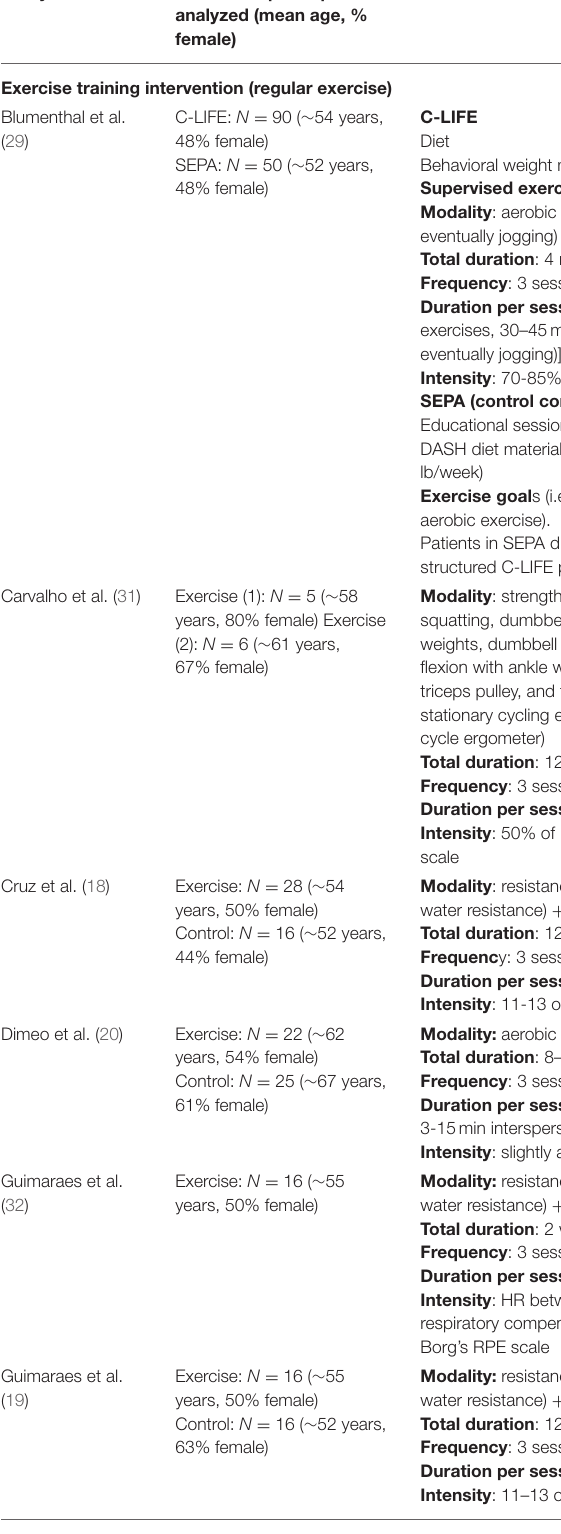
TABLE 1 | Main characteristics of the included studies. Study Number of participants Exercise intervention Design analyzed (mean age, % female) Exercise training intervention (regular exercise) Blumenthal et al.